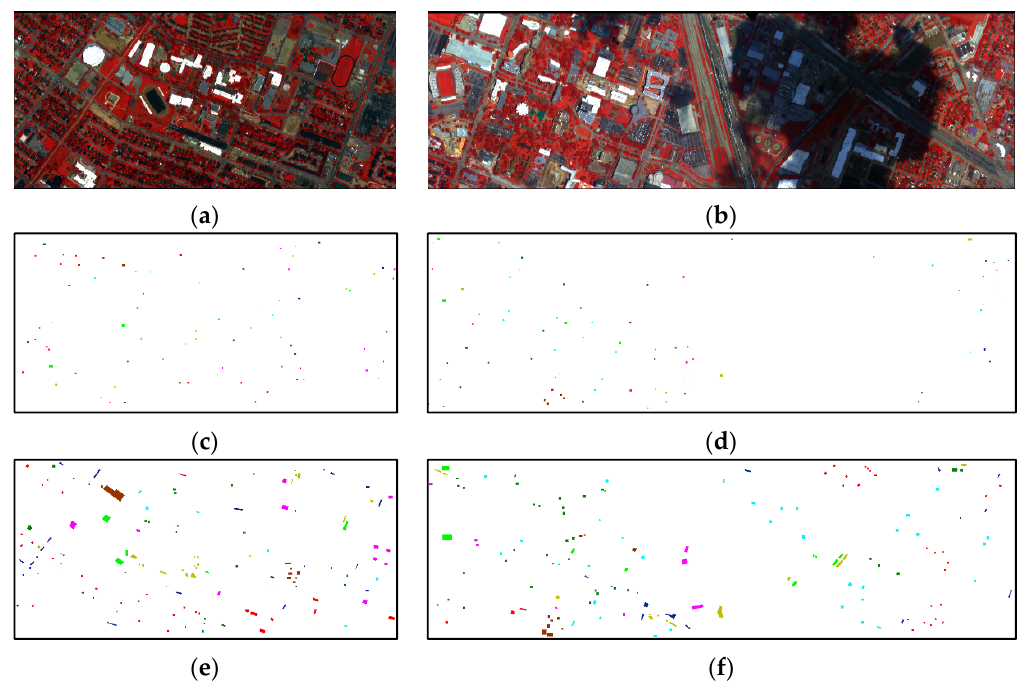
Figure 3. Color composite of the Source ( a ) and Target ( b ) images of Houston with the corresponding ground truths: ( c ) and ( d ) train maps for Source and Target; ( e ) and ( f ) test maps for Source and Target. Table 2. Class legend for Figure 3